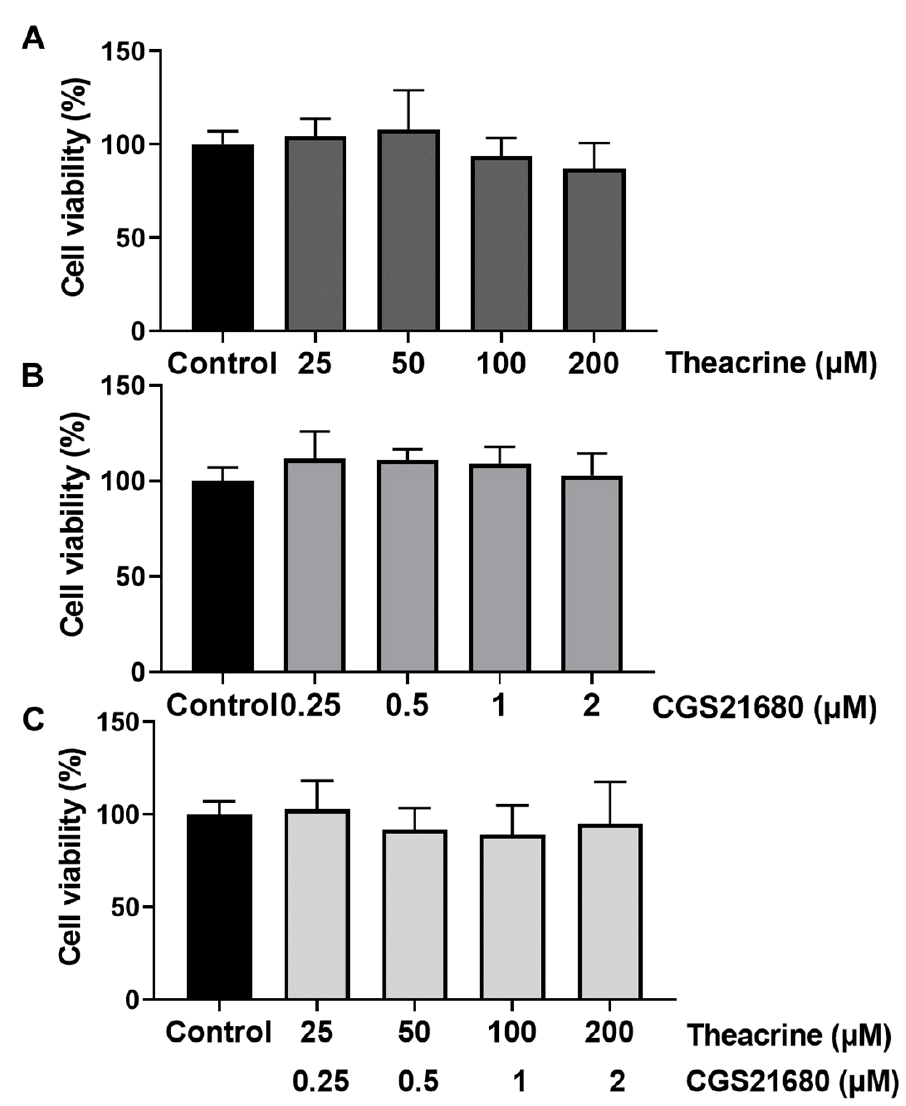
Figure 2. Effects of theacrine and CGS21680 on cell viability in MCF-7 cells. MCF-7 cells were treated with theacrine of 25, 50, 100, and 200 µM ( A ) and/or with CGS21680 of 0.25, 0.5, 1, and 2 µM for 24 h ( B , C ). Cell viability was calculated by the MTT assay. The results were shown as mean ± SD ( n = 6).